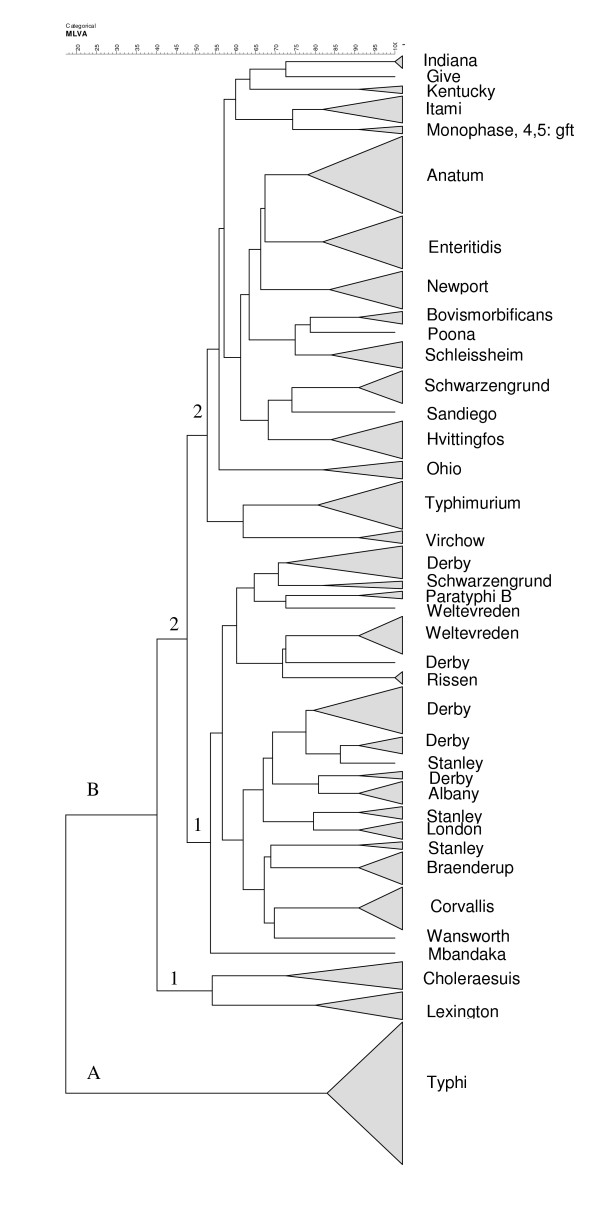
MLVA types distribution of 31 Salmonella enterica serovars using the categorical coefficient and the cluster analysis pairwise similarities (UPGMA). The 206 isolates studied were obtained from three sources: humans (medical microbiology laboratory, 2004-2007, IPC and National Pediatric Hospital, 2005), animals (a study of food microbiology laboratory, IPC and Animal Health Department, Ministry of Agriculture, Forest and Fishery, Cambodia, 2003-2004) and from the Action de Concertation Inter-Pasteurienne (poulet project, 2006-2007) and food (food microbiology laboratory, 2001-2007, IPC).